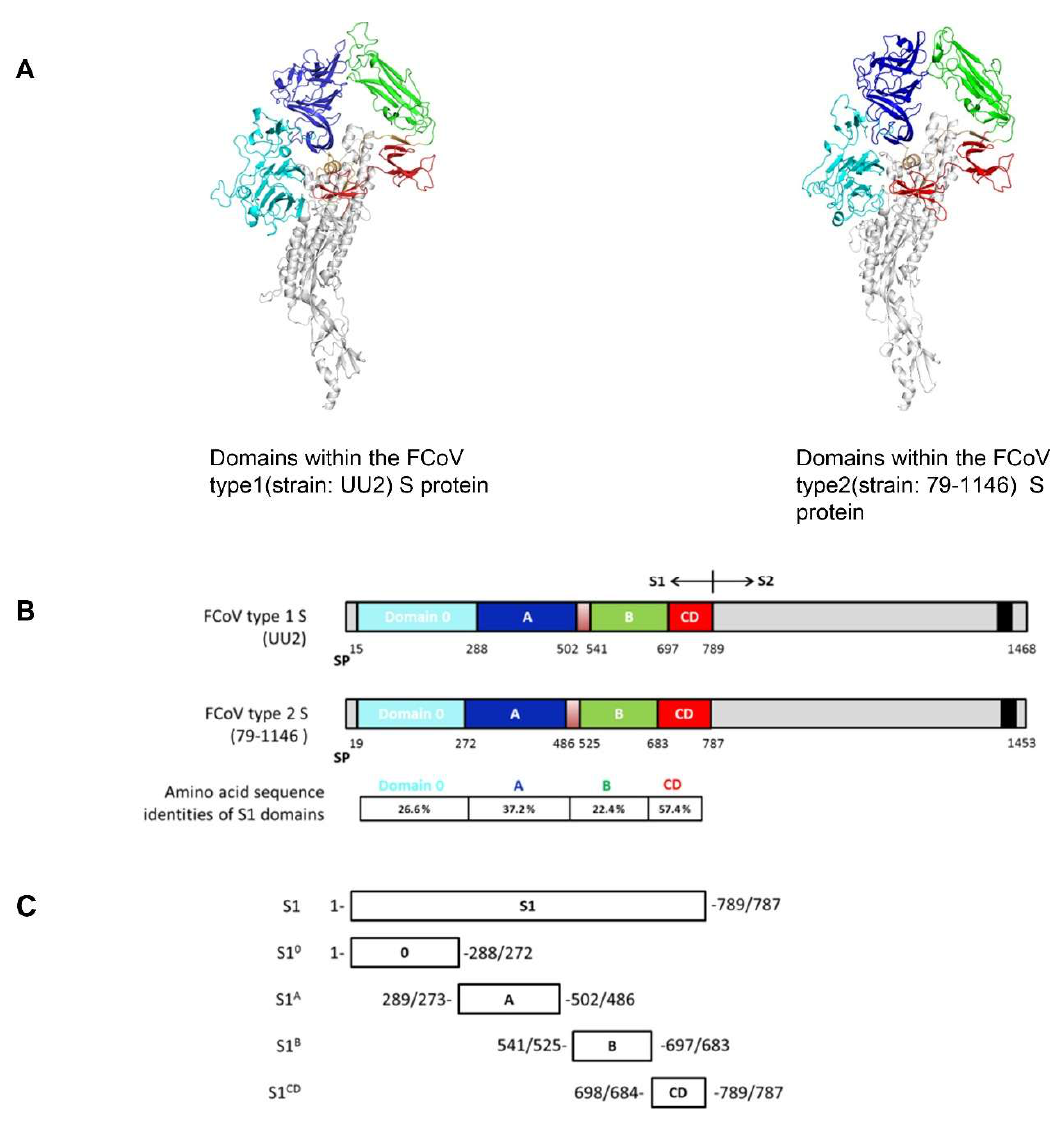
Figure 2. Domains within the FCoV type 1 and type 2 spike (S) proteins. ( A ) Structure model of two types of FCoV S trimer based on the HCoV-NL63 S structure were generated via the SWISS-MODEL Homology Modeling server using ProMod3. Figures were produced by PyMOL. Different domains of the S1 subunit of one protomer are colored, with S1 0 shown in cyan, S1 A in blue, S1 B in green, and the domains S1 CD in red. The S2 part of the protomer is marked in light gray. ( B ) Schematic presentation of the FCoV type 1 (strain UU2) and type 2 (stain 79-1146) S protein with the signal peptide (SP), the S1 subunit (the domains are colored as described in the legend of Figure 2A) and the S2 subunit (the C-terminal transmembrane domain is indicated by a black box). Amino acid sequence identities between FCoV type 1 and type 2 S1 domains are indicated. ( C ) Diagram of the different S1 subdomains sequence. All S1 subdomains were C-terminally tagged with the Fc part of mouse IgG2a (not shown in the figure) and expressed as Fc fusion proteins.